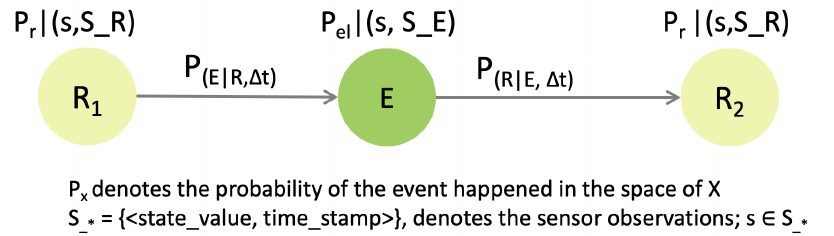
Figure 7. An intuitive example shows the Bayesian